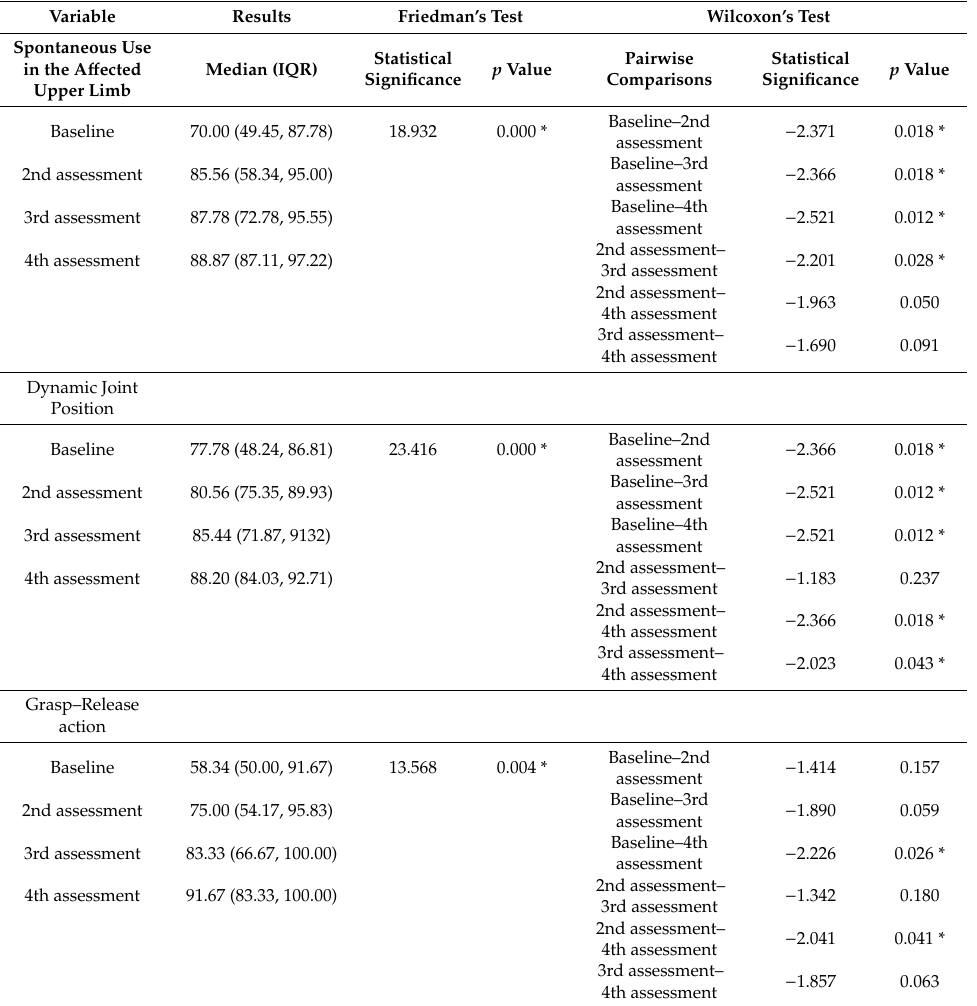
Table 7. Results and pairwise comparisons of spontaneous use, dynamic joint position and grasp–release action.